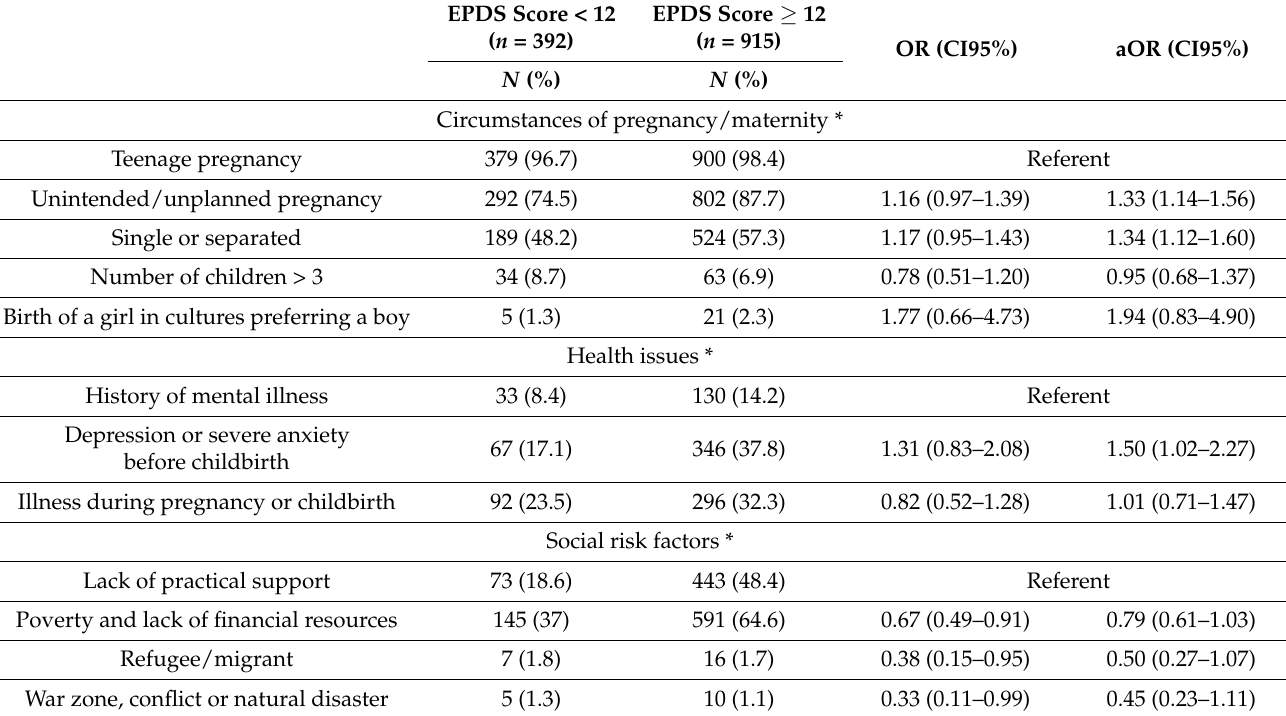
Table 3. Perinatal depression risk